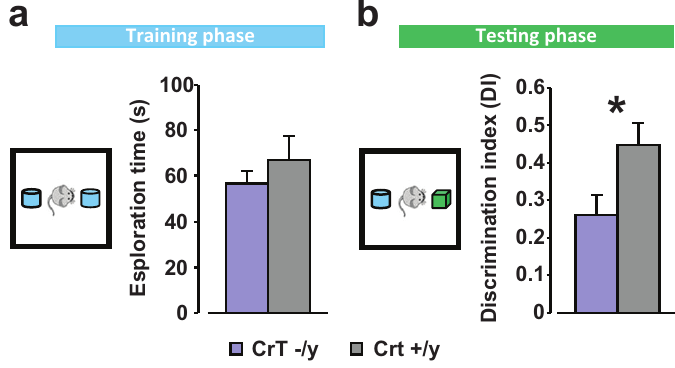
Figure 4. CrT deletion leads to cognitive deficits in object recognition memory. ( a ) On the left, a schematic representation of the sample condition in object recognition task. Histograms depict the performance of CrT –/y and CrT +y during the sample phase: no difference in the total exploration time of objects was detected between the experimental groups (CrT –/y : n = 8, exploration time = 56.91 ± 5.40 s; CrT +/y : n = 6, exploration time = 67.20 ± 10.23 s; t test, p = 0.358). ( b ) On the left, a schematic diagram of the test condition. Histograms display object discrimination indexes of CrT –/y and CrT +y during the testing phase: a significantly lower discrimination index was found in CrT –/y mice (0.261 ± 0.053) compared to CrT +y animals (0.448 ± 0.059; t test, p < 0.05). *, statistical significance. Error bars, s.e.m.